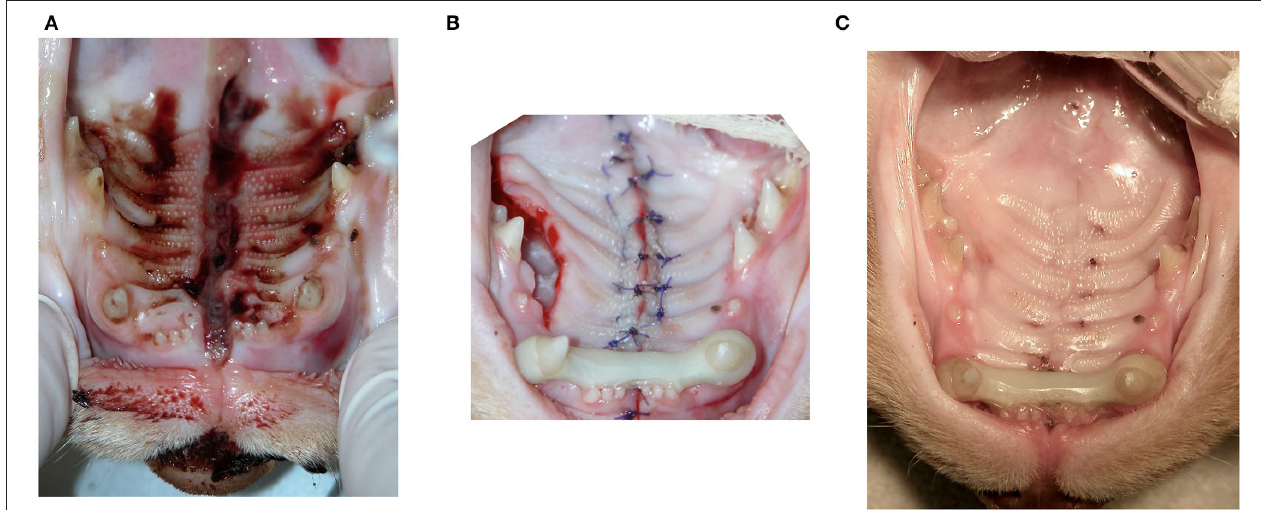
FIGURE 4 | Unilateral pedicle flap technique with lateral releasing incision and the interquadrant splinting between the right and left maxillary canine teeth. (A) Wide acquired midline palate defect (PDE) extending from the level of the incisor teeth to the rostral aspect of the soft palate. (B) Following the closure of the mucoperiosteal tissue edges in one layer (alternating horizontal mattress and simple interrupted pattern), a splint between the right and left maxillary canines was placed to reduce and stabilize the median palatine suture separation. (C) Five-week postoperative image before removal of the splint. The PDE is healed, and the denuded bone in the area of the lateral releasing incision is completely